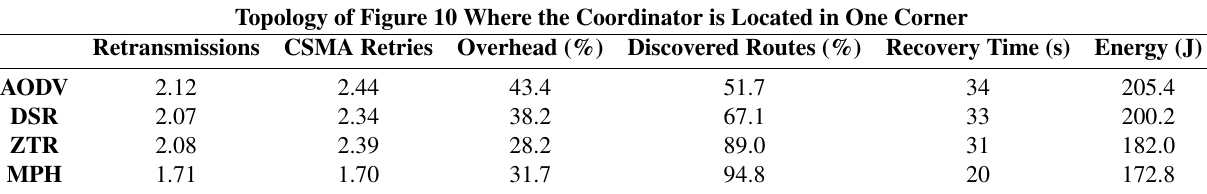
Table 5. Grid topology where the coordinator is located in one corner.